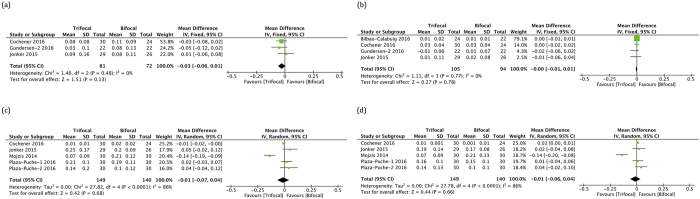
Pooled mean differences (MDs) for uncorrected distance visual acuity (UDVA), corrected distance visual acuity (CDVA), uncorrected near visual acuity (UNVA) and distance-corrected near visual acuity (DCNVA) in logMAR by meta-analysis.(a) Forest plot showing the MD of UDVA comparing trifocal intraocular lens (IOL) with bifocal IOL postoperatively (only for RCTs). (b) Forest plot showing MD of CDVA comparing trifocal IOL with bifocal IOL postoperatively (only for RCTs). (c) Forest plot showing the MD of UNVA comparing trifocal IOL with bifocal IOL postoperatively. (d) Forest plot showing the MD of DCNVA comparing trifocal IOL with bifocal IOL postoperatively.